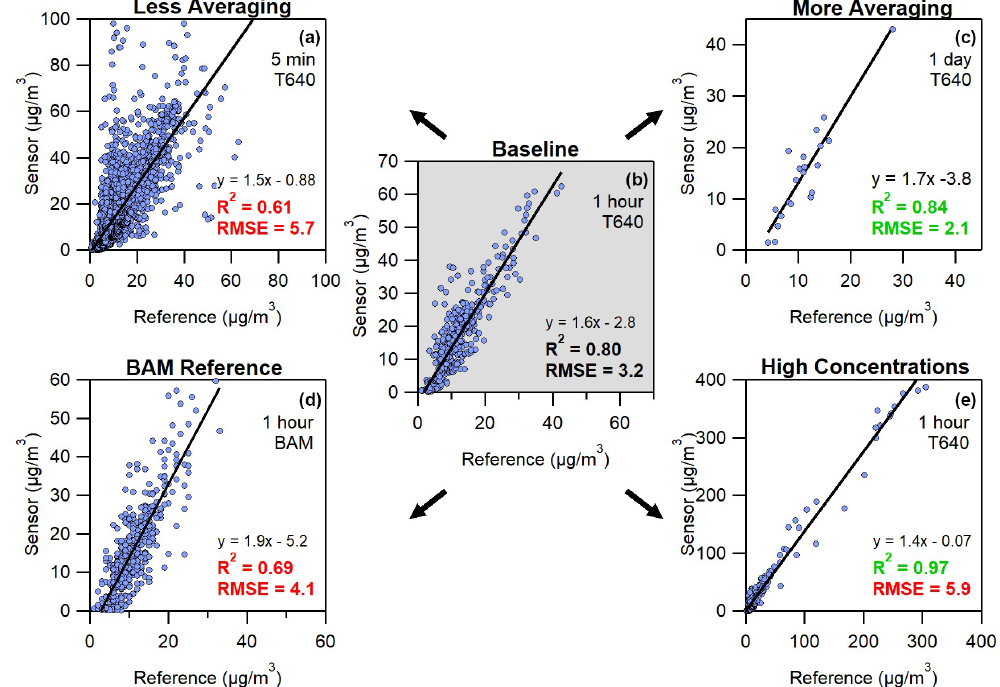
Figure 3. The changes to R 2 and RMSE from a baseline condition depending on evaluation conditions. Panel (b) shows the baseline of 1h averaged data with T640 as a reference instrument and without 3d of high concentrations. Panels (a) and (c) show the impact of less and more data averaging, respectively. Panel (d) shows the impact of switching to the BAM instead of the T640. Panel (e) shows the effect of high concentration by including 3 additional days during which higher concentrations were